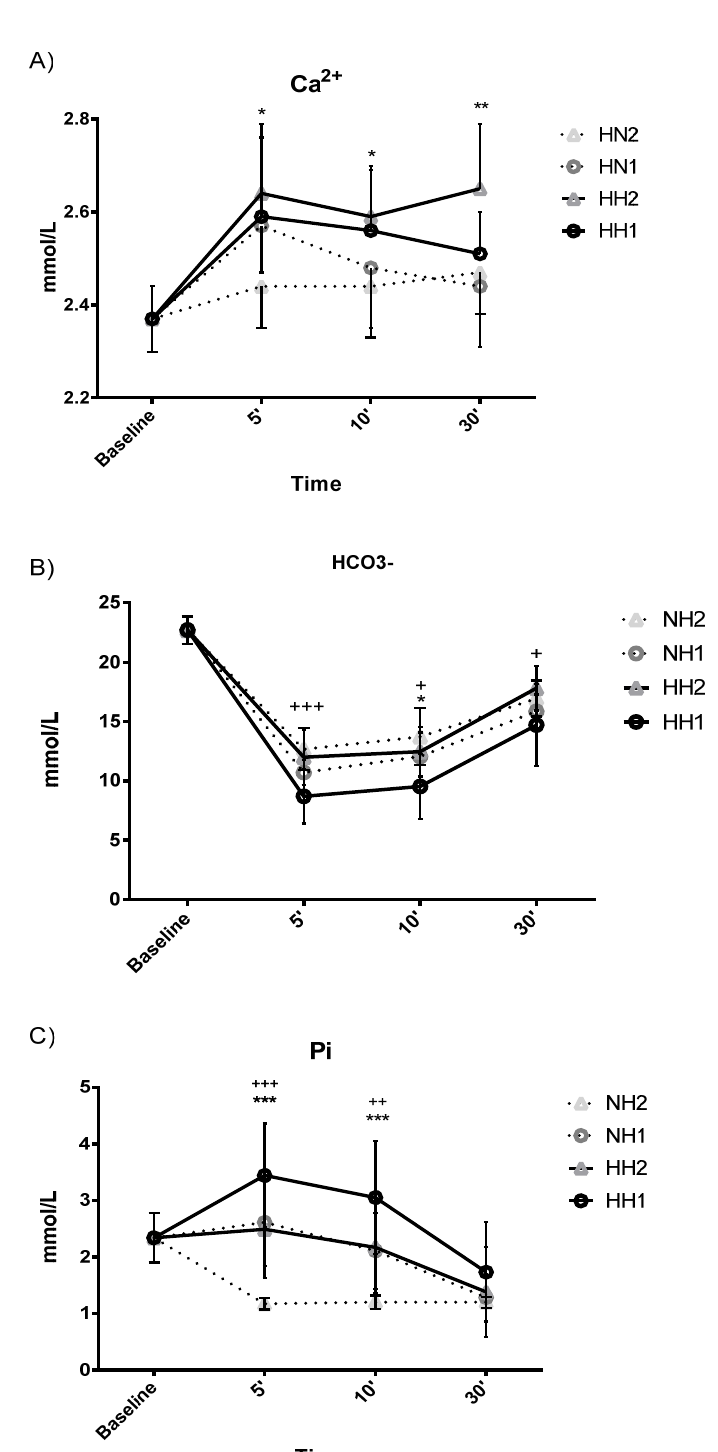
Figure 2. Circulating ions after resistance training sessions [sub-picture ( A ): Ca 2+ , sub-picture ( B ): HCO 3 − and sub-picture ( C ): Pi]. Hypobaric hypoxia (HH) vs. Normobaric hypoxia (NH) with different inter-set rest (1 vs. 2 min). NH2 and NH1: Normobaric Hypoxia with 2-min inter-set rest and 1-min rest. HH2 and HH1: Hypobaric Hypoxia with 2-min inter-set rest and 1-min rest. + p < 0.05, ++ p < 0.01, +++ p < 0.001 comparing 1-min inter-set rest vs. 2 min rest over time. * p < 0.05, ** p < 0.01, *** p < 0.001 comparing HH vs. NH over time.